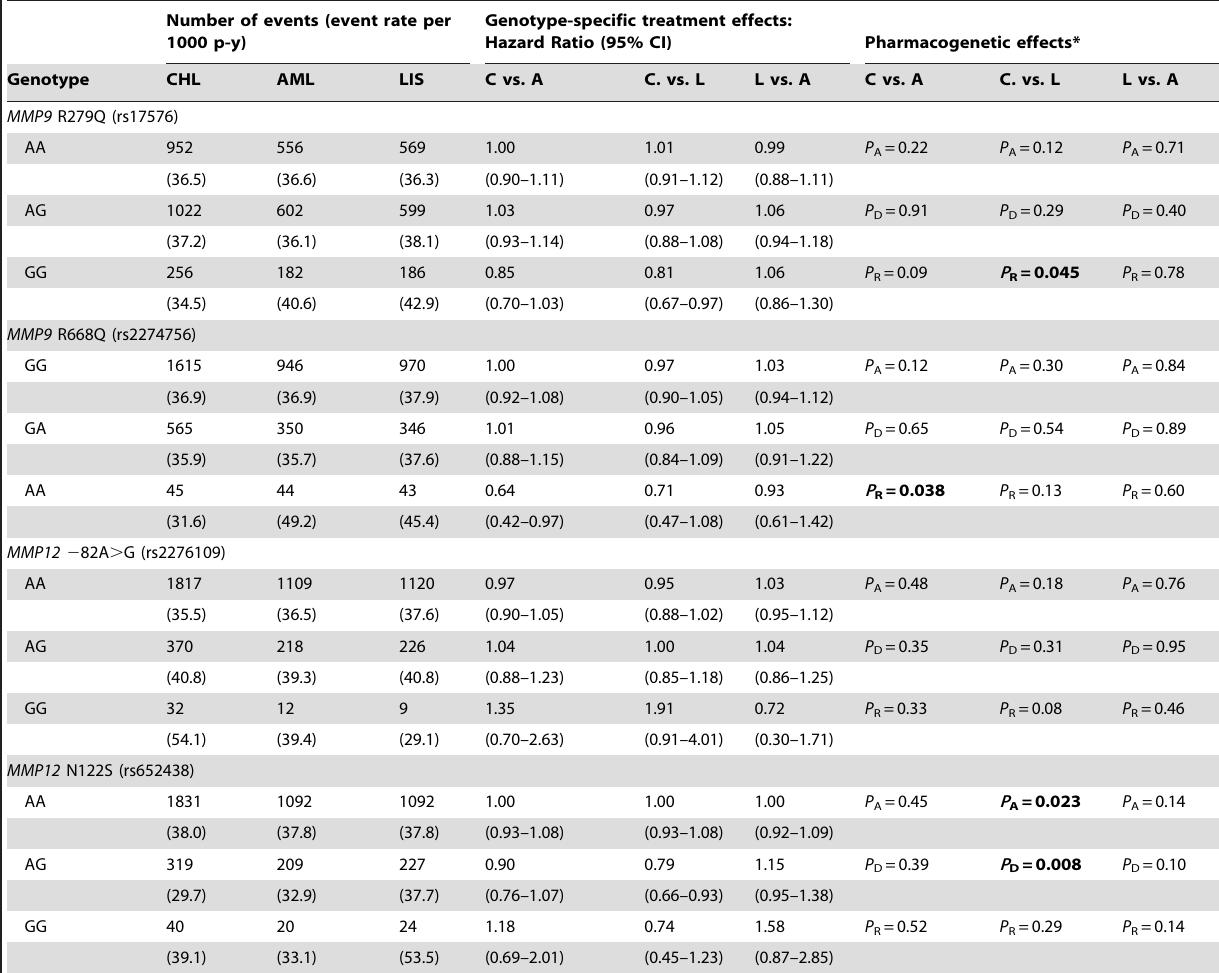
Table 4. Pharmacogenetic effects of MMP genetic variants on